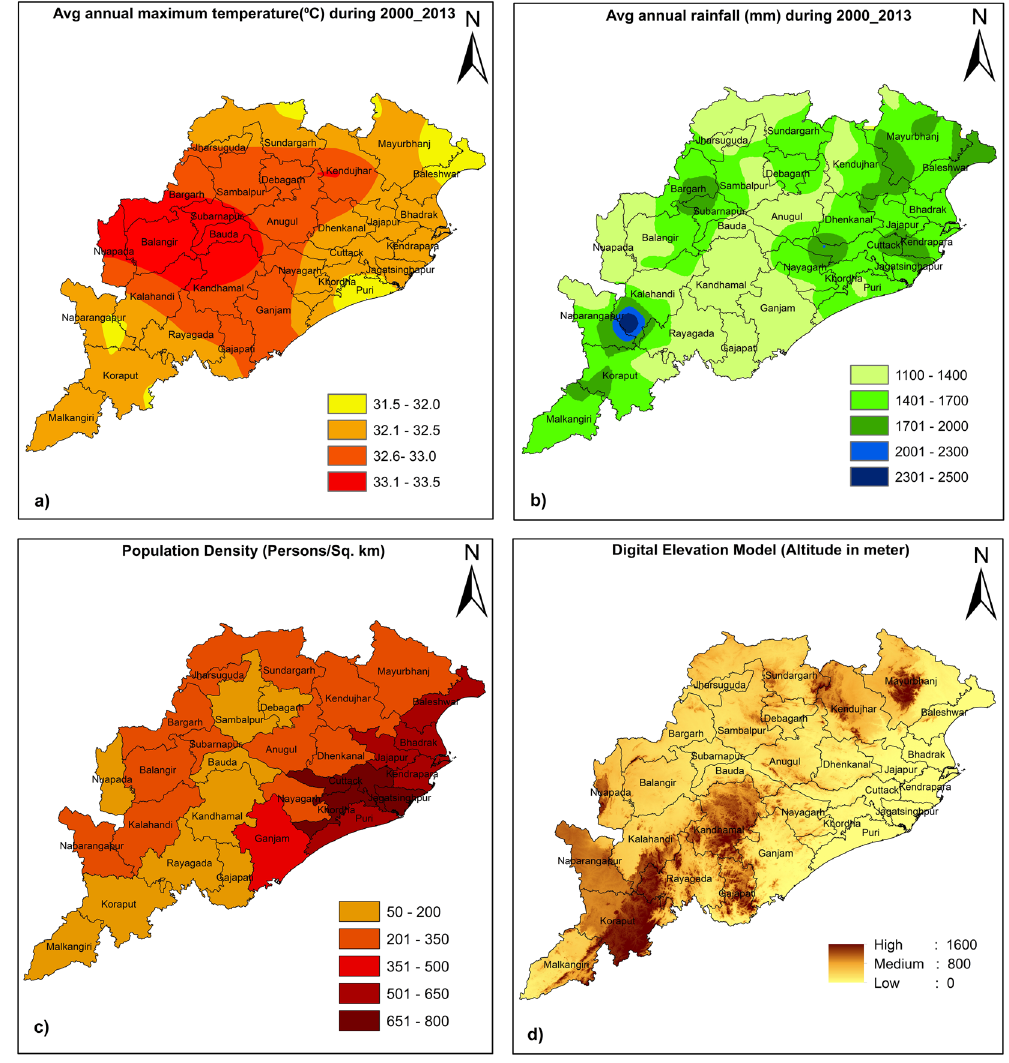
Figure 2. ( a ) Climatological (2000–2013) observed annual average daily maximum temperature (°C), ( b ) annual rainfall accumulation (mm), ( c ) district-wise population density as per the 2011 census, and ( d ) elevation from sea